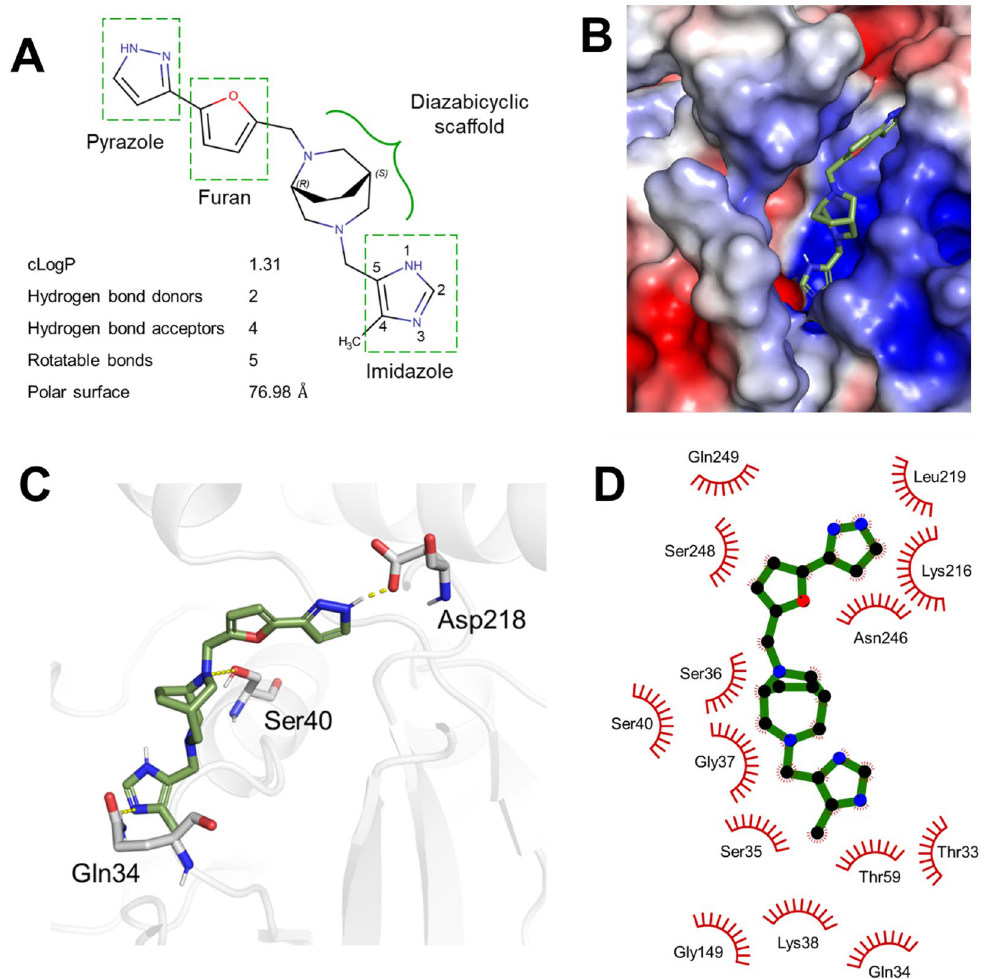
Figure 6. Molecular interactions of DRP1i27 at the active site of Drp1. (A) Chemical structure and physicochemical properties of DRP1i27. (B) Representative image of DRP1i27 in the active site of human Drp1 protein. Protein surface was coloured according to electrostatic potential of surface residues. Dark red, negative charge; Dark blue, positive charge. White, neutral charge. (C) 3D representation of hydrogen bonding interactions and (D) 2D representation of hydrophobic interactions of DRP1i27 at the active site. For clarity, non-polar hydrogen atoms are hidden from view. Secondary structure of the active site is depicted as light grey cartoon. Yellow dashed lines indicate hydrogen bonds. Blue, nitrogen atom; Red, oxygen atom. Lime green and gray stick backbones, carbon atom. Interactions were predicted using PyMOL v2.5.2 and LigPlot